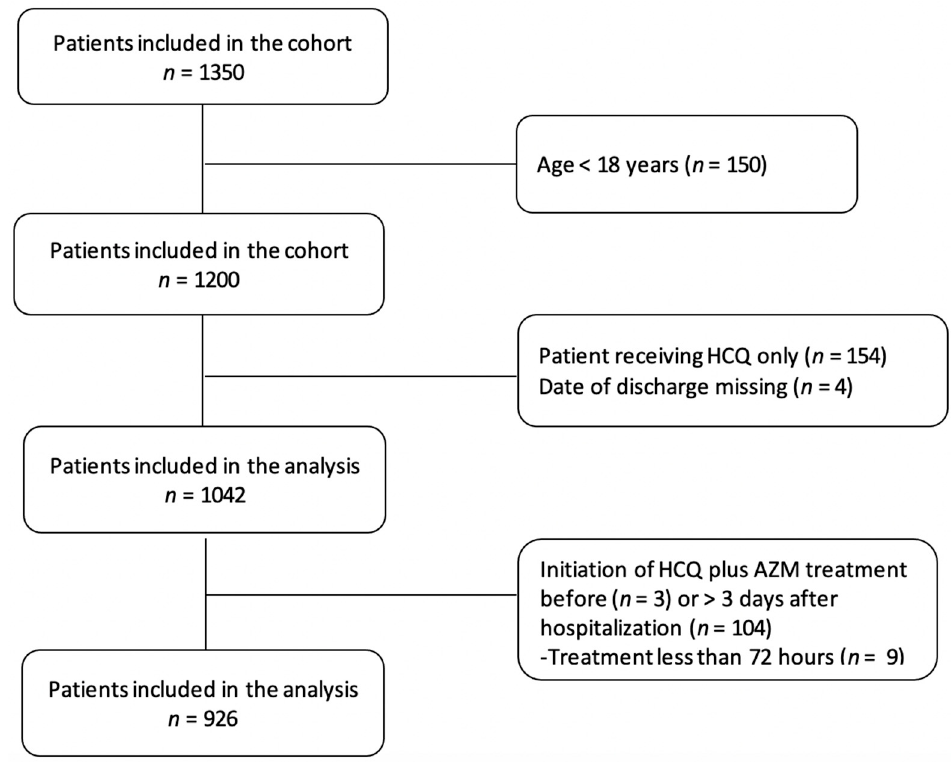
Figure 1. Flowchart of participants included in the Cohort study. HCQ: hydroxychloroquine; AZM: azithromycin.